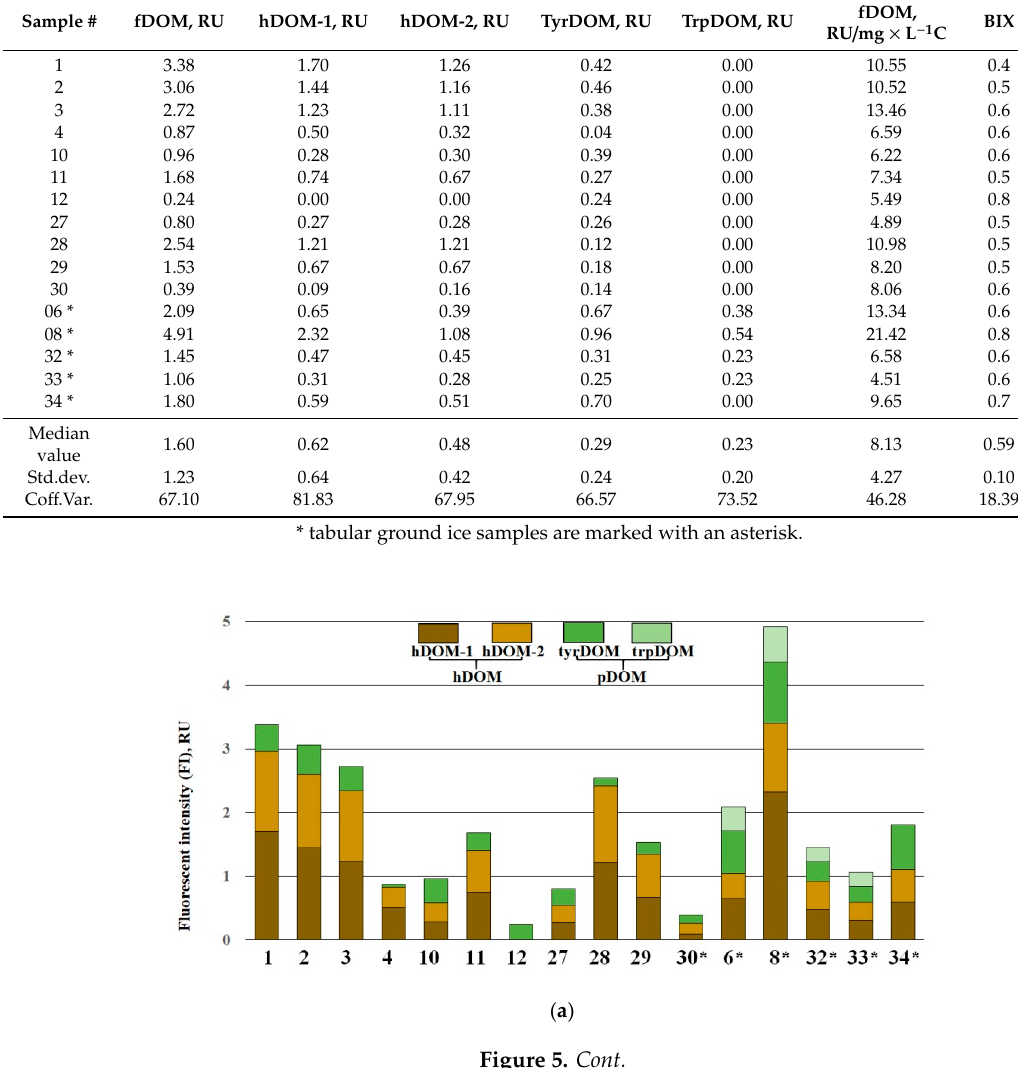
( b ) Figure 5. Distribution of fluorescent DOM (fDOM). ( a ) The molecular fractions of fDOM; ( b ) Distribution of the integral humic-like DOM (hDOM) and protein-like DOM (pDOM) values normalized to Dissolved organic carbon (DOC) concentration (Carbon-normalized values). * tabular ground ice (TGI) samples are marked with an asterisk.